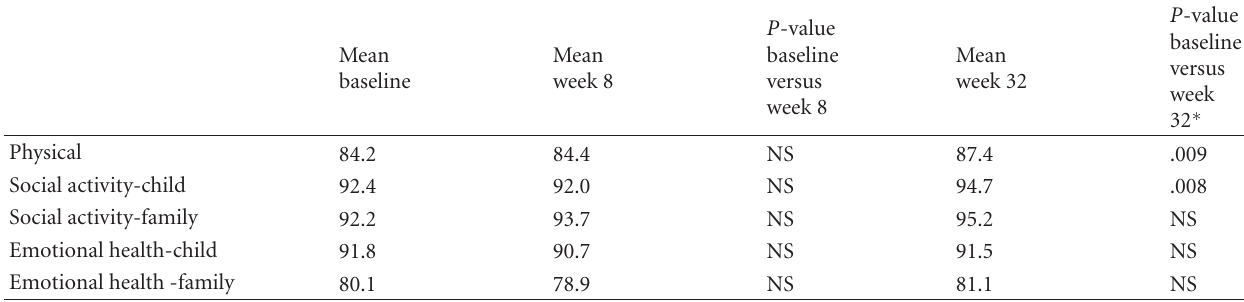
Table 3: Functional health outcomes child health survey of asthma.